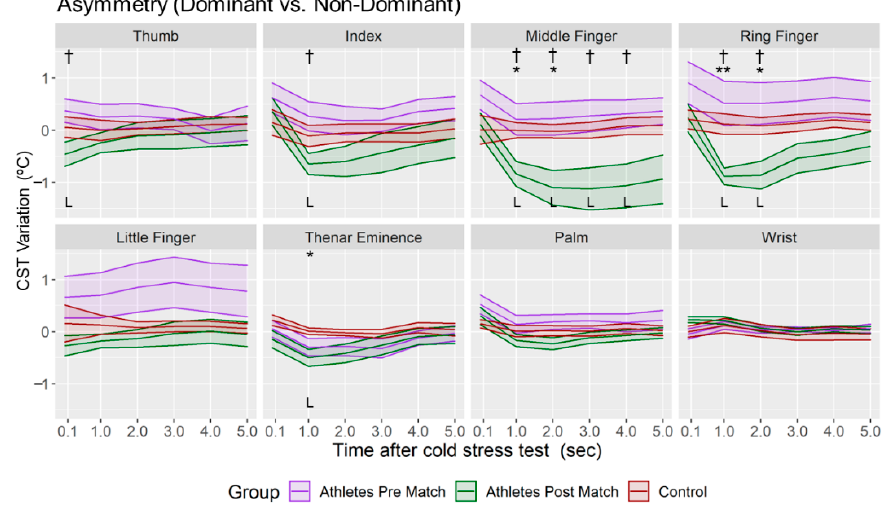
Figure 5. Mean and standard deviation of the CST variations of the asymmetries for each minute after CST in all the groups. L = Large Effect Size. Difference between Athletes Group—Post Match and Athletes Group—Pre Match († p < 0.05); Difference between Control Group and Athletes Group—Post Match (* p < 0.05; ** p < 0.01).